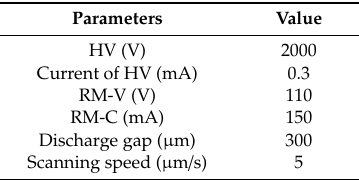
Table 5. Experimental